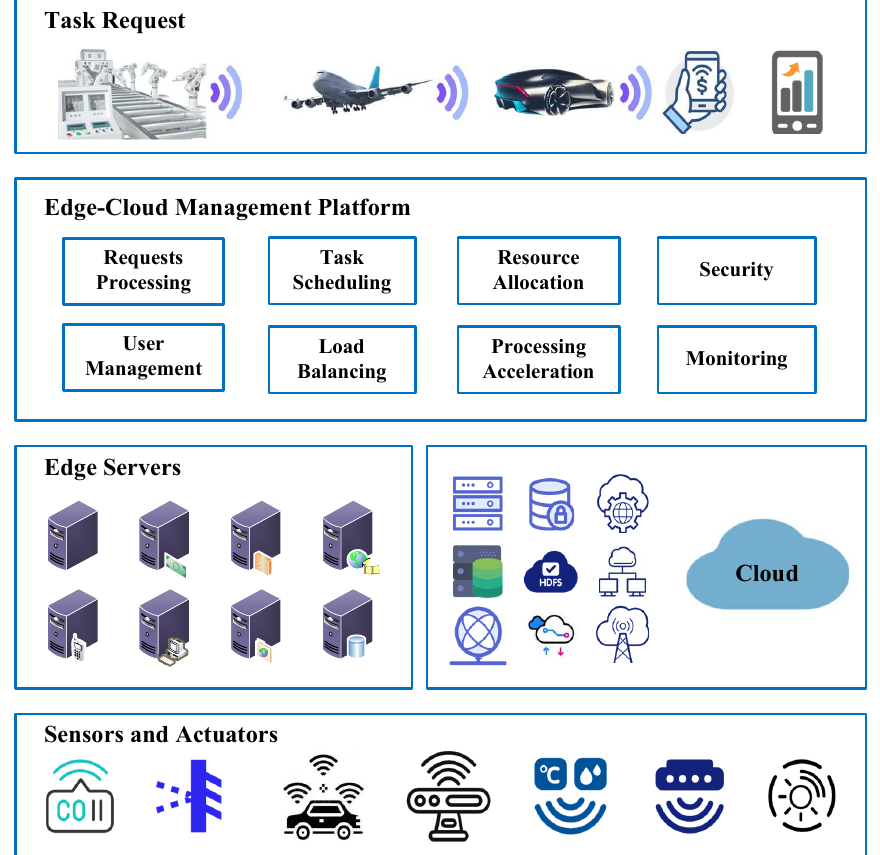
Figure 1. Layered architecture for edge-cloud collaborative